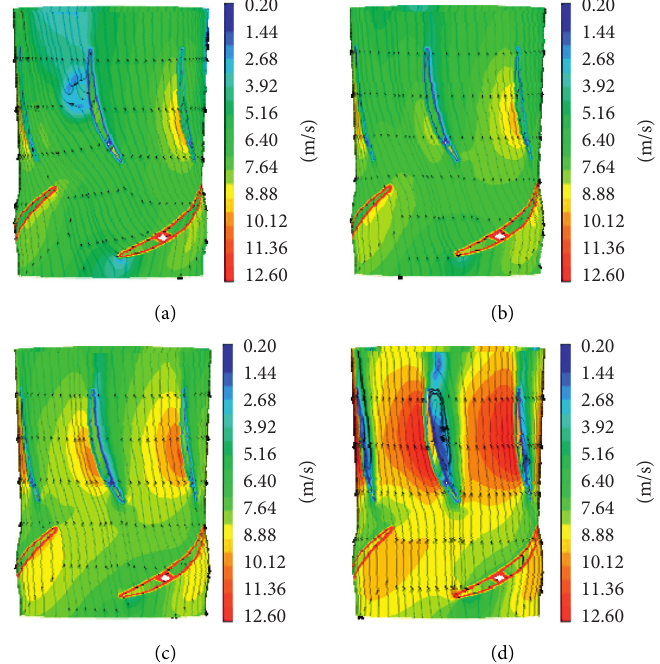
Figure 10: Flow fields in the pump segment under different conditions of discharge rates ( Δ β � +5 ° , h � 0 . 25 H ). (a) Q � 0.30 m 3 /s, (b) Q � 0.35 m 3 /s, (c) Q � 0.40 m 3 /s, and (d) Q � 0.45 m 3 /s.